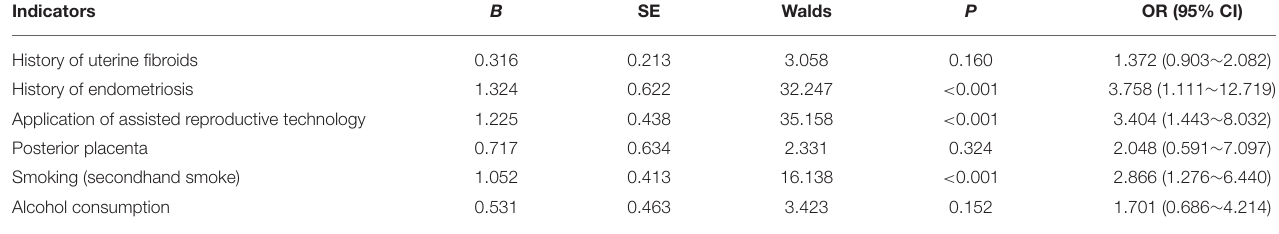
TABLE 3 | Multifactorial analysis of PP in first-time pregnant patients. Indicators